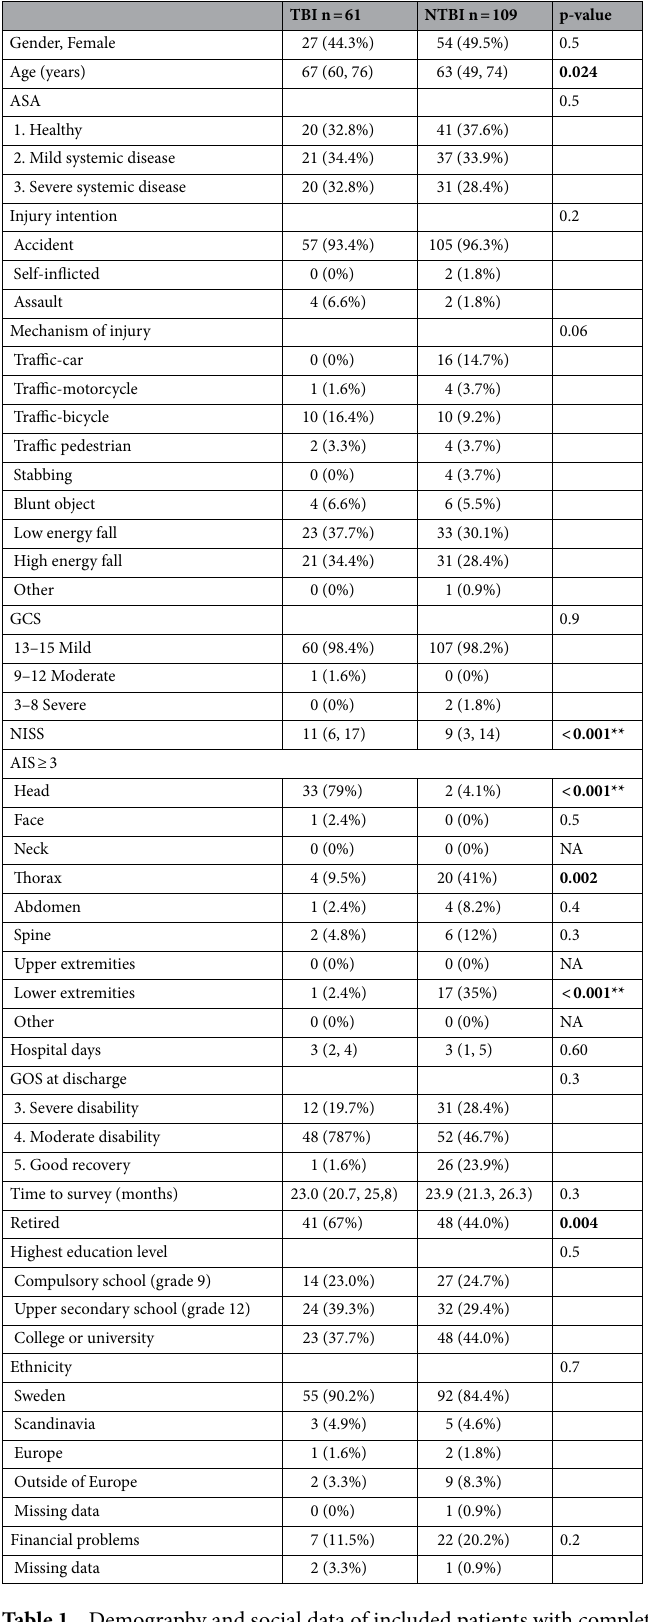
Table 1. Demography and social data of included patients with complete data, eligible for follow-up. Results expressed in median and (IQR) as well as numeric values and (%). ASA American Society of